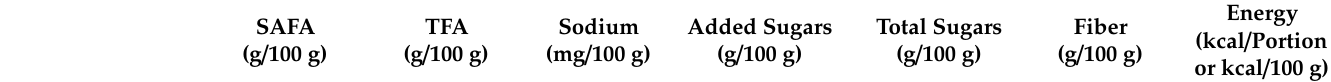
Table 4. Choices International Criteria